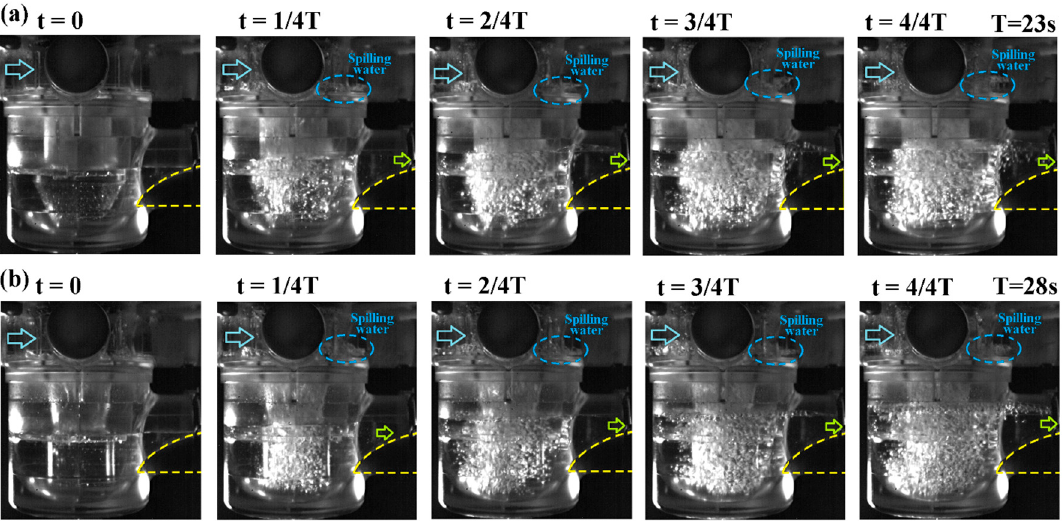
Figure 8. Flow snapshots for gullies with: ( a ) beveled; and ( b ) downward nozzle flows at 0.6 L/s.